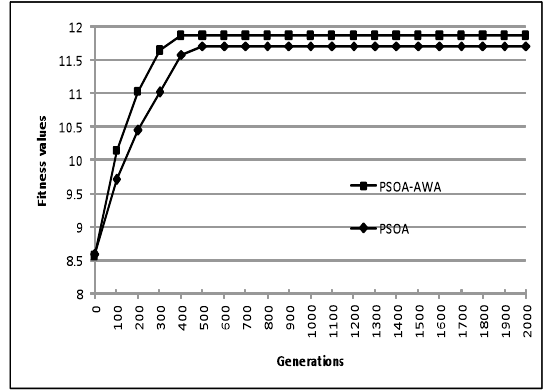
Fig.7 Fitness comparisons for AWA